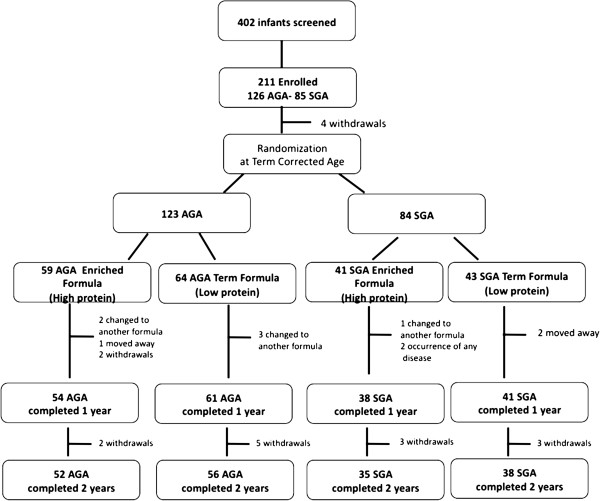
Flow chart of the study.